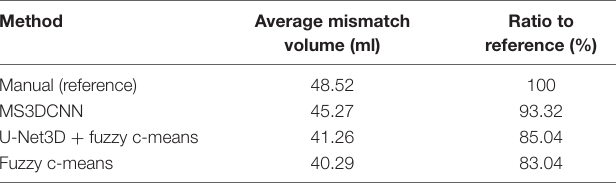
TABLE 5 | The average mismatch volume and ratio to reference of the automated methods and the manual